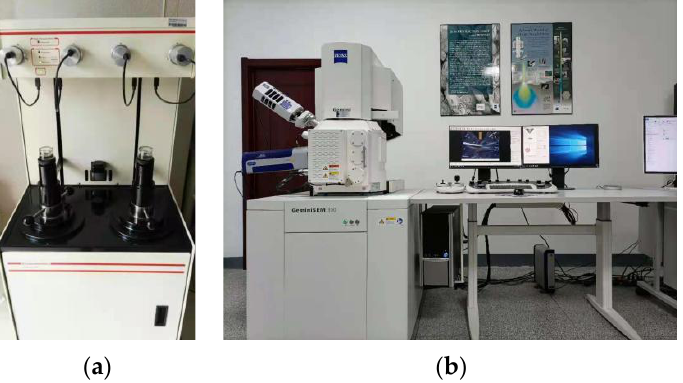
Figure 8. Test instruments: ( a ) Mercury porosimeter; ( b ) Scanning electron microscope